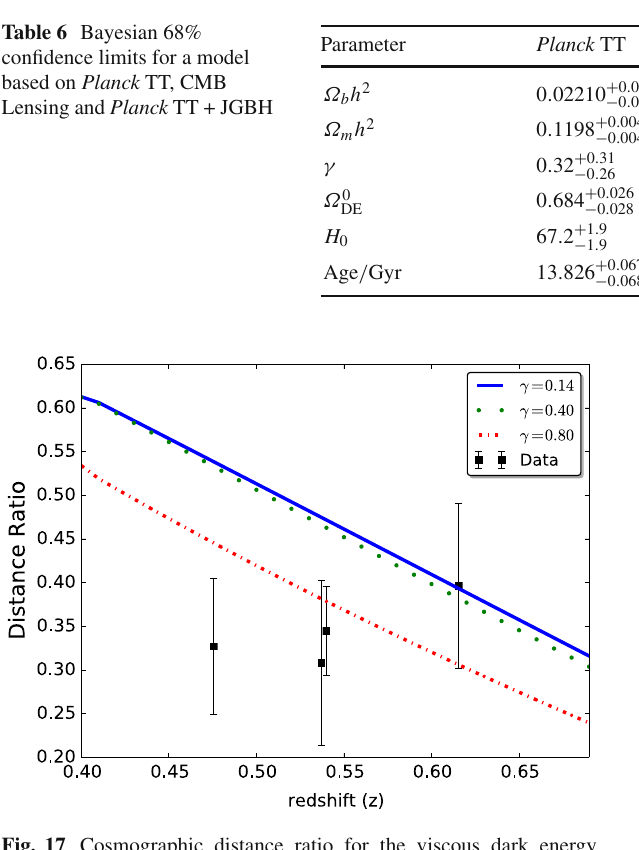
Fig. 17 Cosmographic distance ratio for the viscous dark energy model. The solid line corresponds to γ = 0 . 14 according to best fit by JLA observation, a dotted line indicates the case γ = 0 . 40 and a dash-dot line is for γ = 0 . 80. Observed data are given from